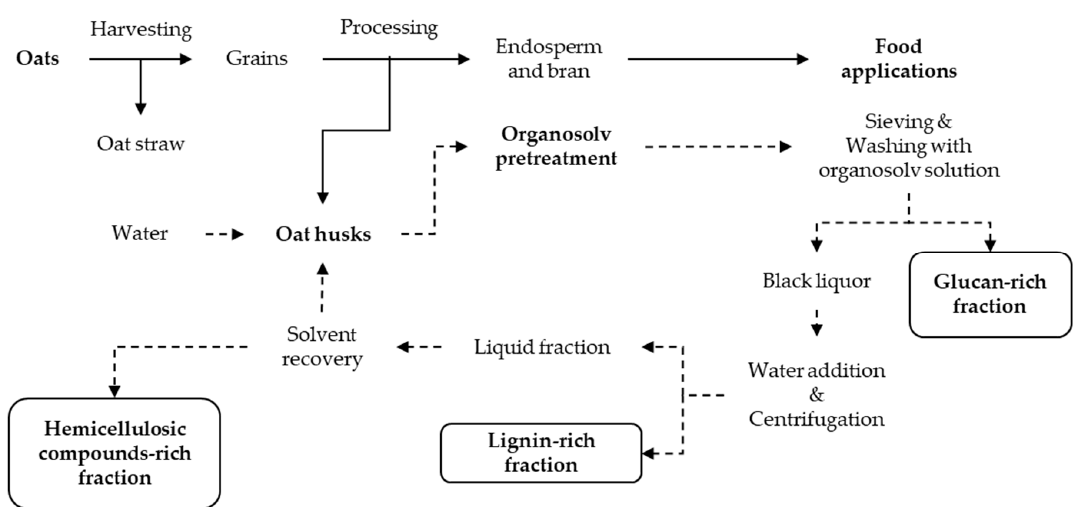
Figure 1. Overall scheme of lignocellulosic byproducts originating from oat harvesting and processing. Oat husks are valorized through organosolv pretreatment, wherein three separate high-quality streams, indicated in the square blocks, are produced to be further biorefined and used in a wide range of applications.